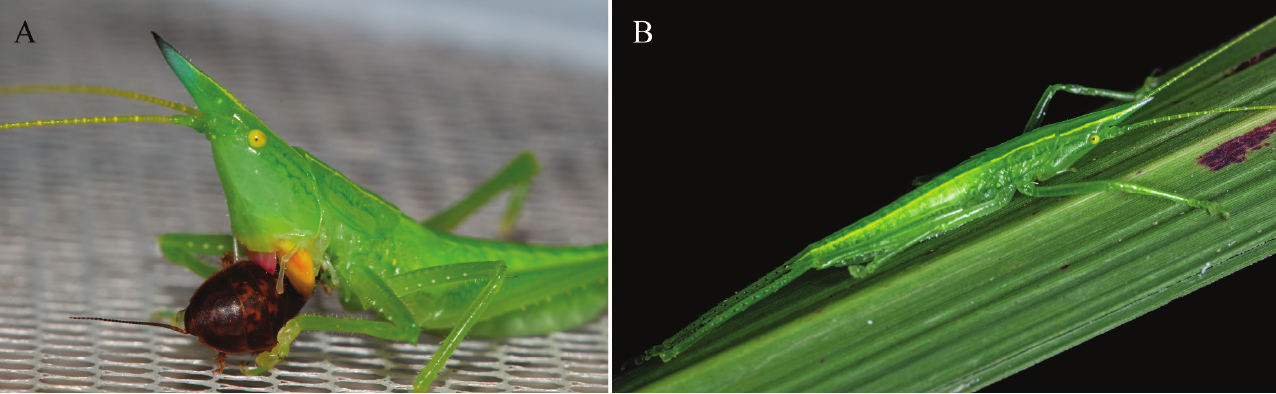
Fig. 6. Toledopizia salesopolensis in vivo. A. Nymph feeding on a cockroach; B. Male on a bamboo